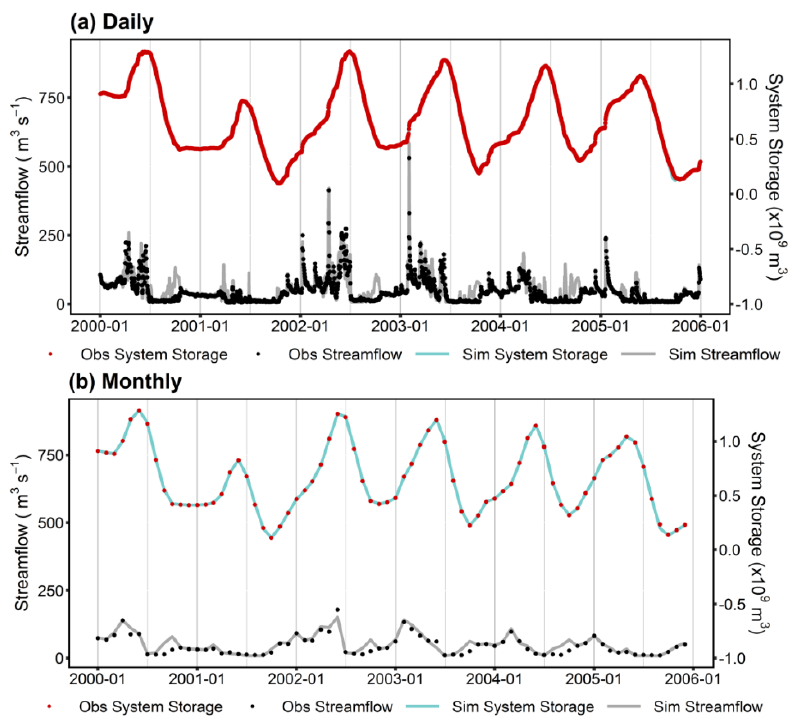
Figure 8. Observed and simulated streamflow and system water storage at Parker station from 2000 to 2005 for ( a ) daily values; and ( b ) average monthly values.